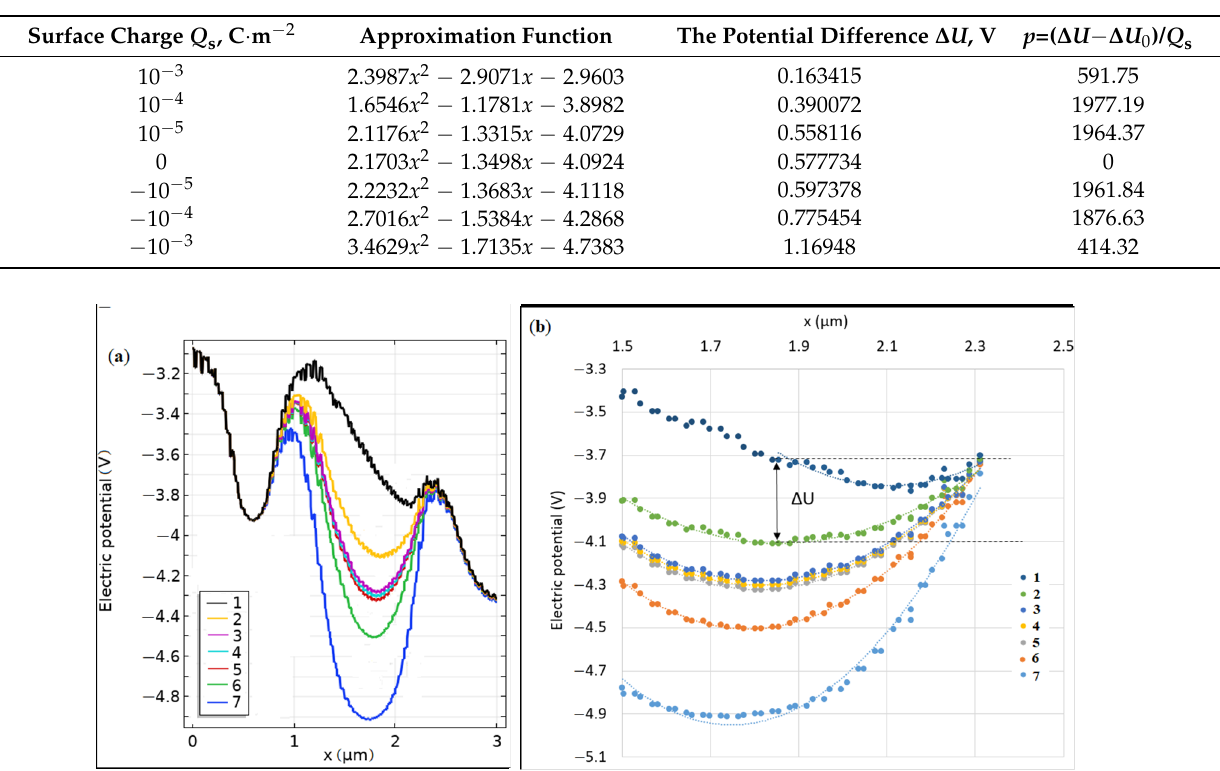
Figure 3. Electric potential distribution at different surface charge density values on two scales on the X -axis. The cutline Y = 0.5 μ m, U ct = 0.5 V, U an = 1 V, U g = 3 V. The target is GaAs, p -type, the dopant concentration equal p = 10 12 cm − 3 . Barrier − height Δ U was determined for each curve between the cathode potential and the minimum potential (shown for curve number 2). Surface charge values are shown in Table 1 below. Table 1. Surface charge values and corresponding approximation functions for the potential shift.